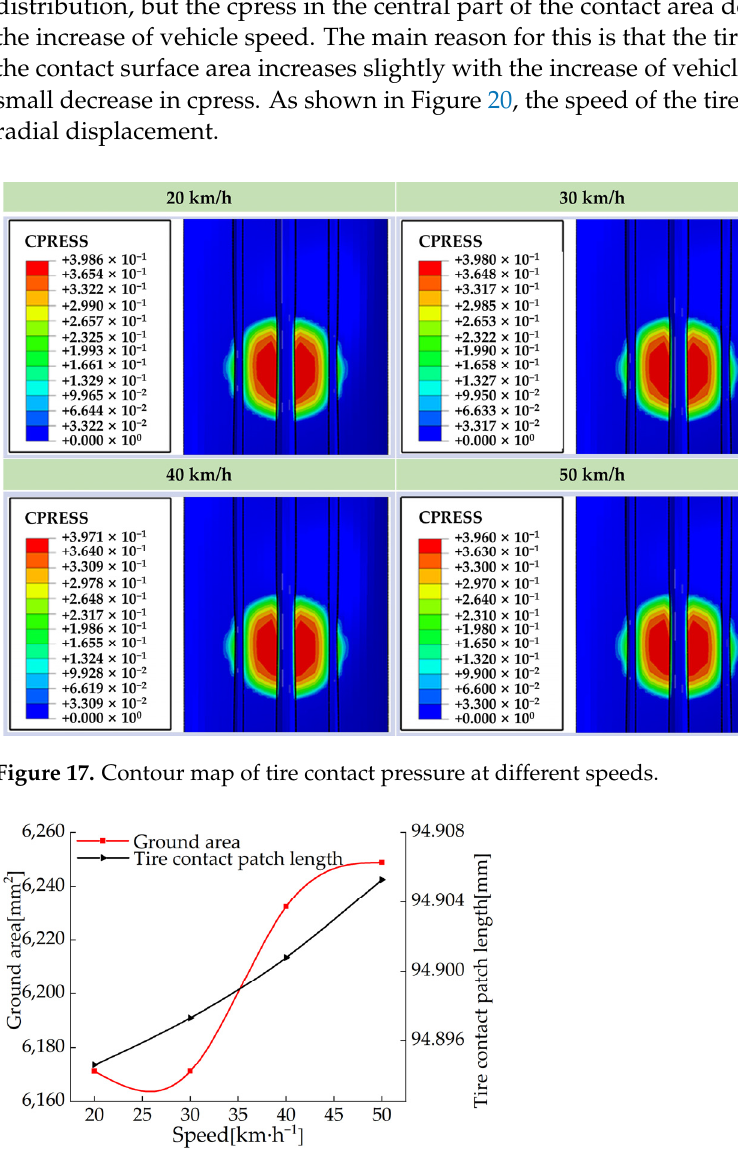
Figure 18. Curves of tire contact area and longitudinal contact length at different speeds.